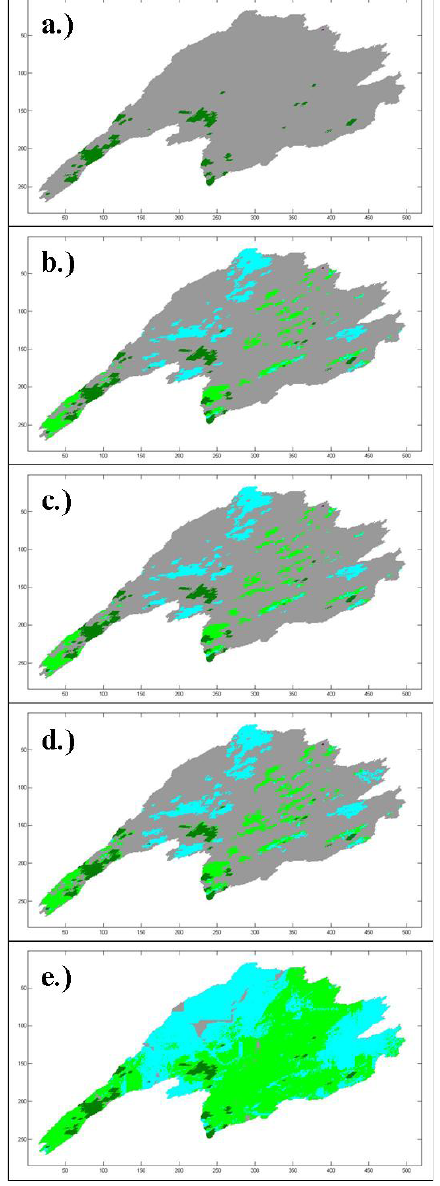
Fig. 7. Example of the sequence results for 18 February 2005; (a) original image, (b) after T/A combination, (c) after time interpo- lation, (d) after spatial interpolation, and (e) after logistic regression (final result).